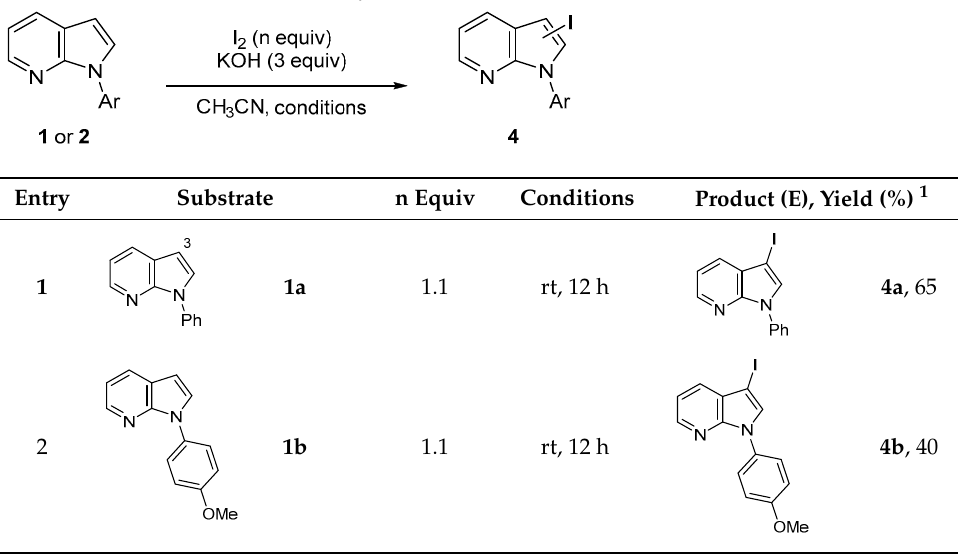
Table 3. Direct iodination of the 1-arylated 7-azaindoles.